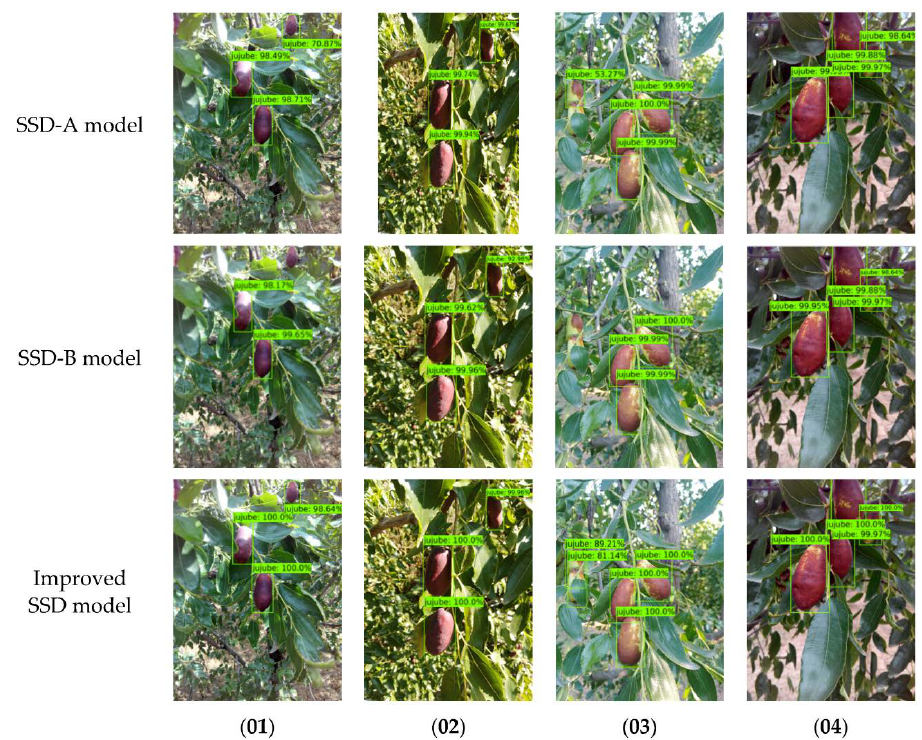
Figure 12. Improved Peleenet network contrast the experimental detection results. ( 01–04 ) The detection outcomes of the three